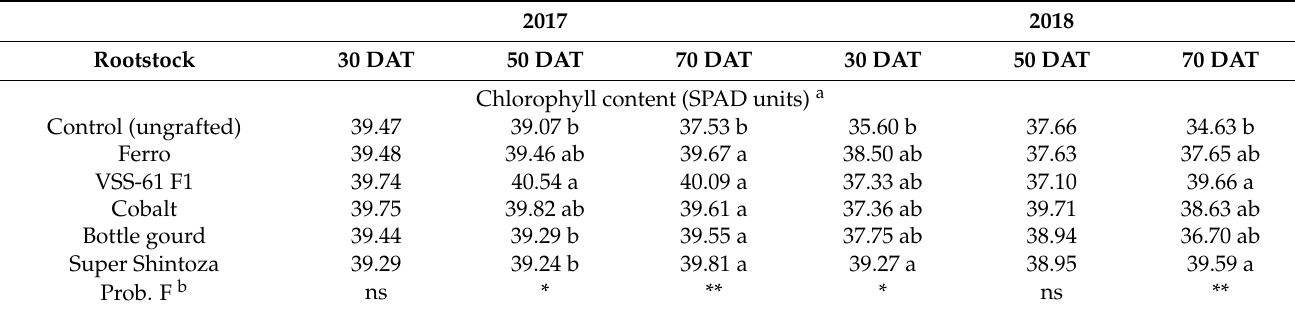
Table 4. Means of leaf chlorophyll content of Gianco F1 cucumber plants grafted onto five cucurbit rootstocks and the ungrafted control under heat and salinity stresses in the 2017 and 2018 seasons. Details on the measurement of the traits presented are provided in the Material and Methods Section.